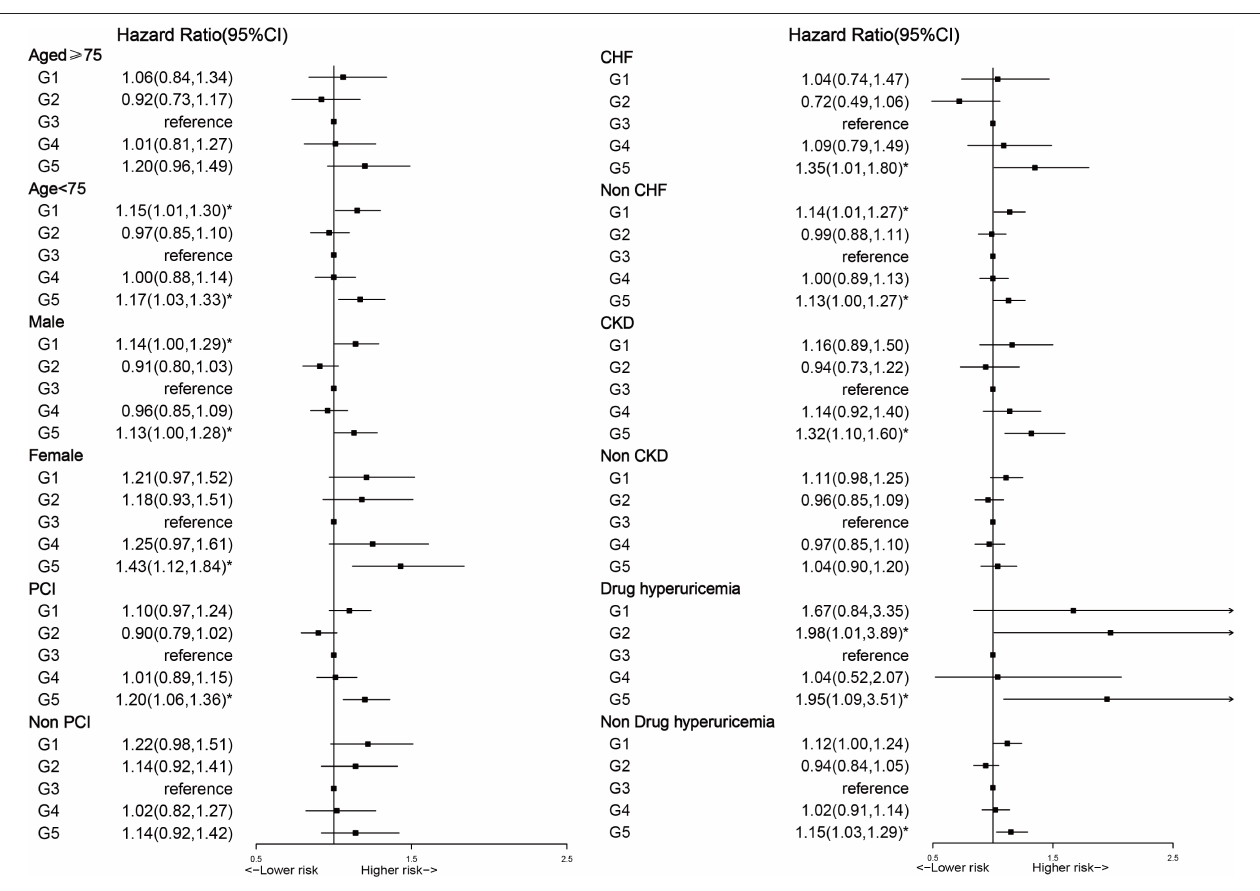
FIGURE 5 | Cox proportional hazard ratios for long-term all-cause mortality in different